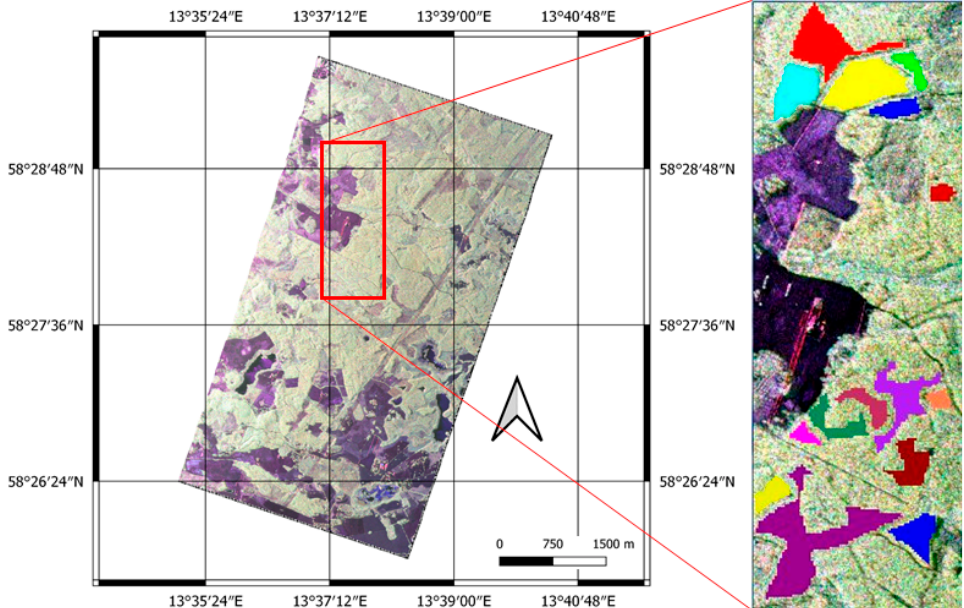
Figure 1. E-SAR pseudo color image on a Pauli basis (HH + VV, HH − VV, and HV are represented by blue, red, and green, respectively) and the fifteen selected stands that are indicated by colorful polygons (red, yellow, green, light blue, blue, orange, purple, violet, dark green, brown, pink, barberry, navy blue, dark red, and Turquoise).